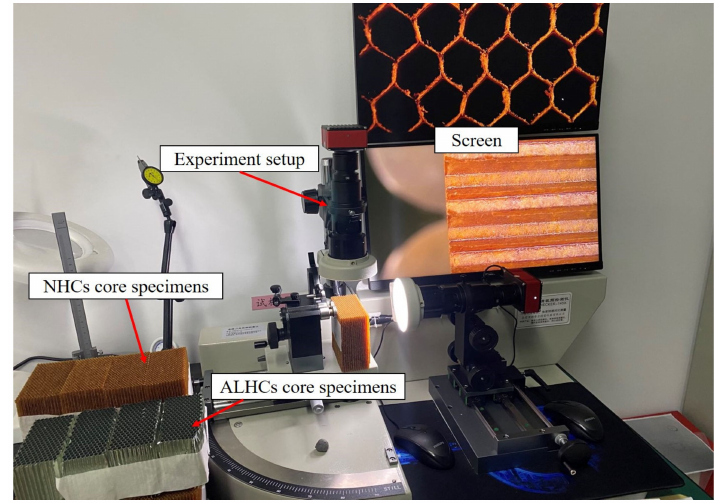
Figure 7. Experimental setup for surface morphology.